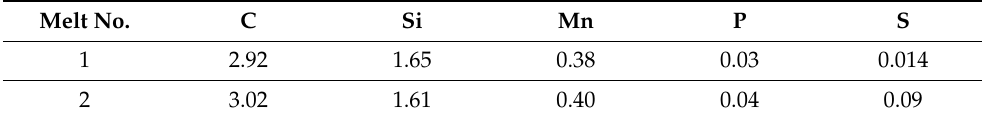
Table 4. Chemical composition of grey cast iron laboratory research (% mass). Melt No. C Si Mn P S